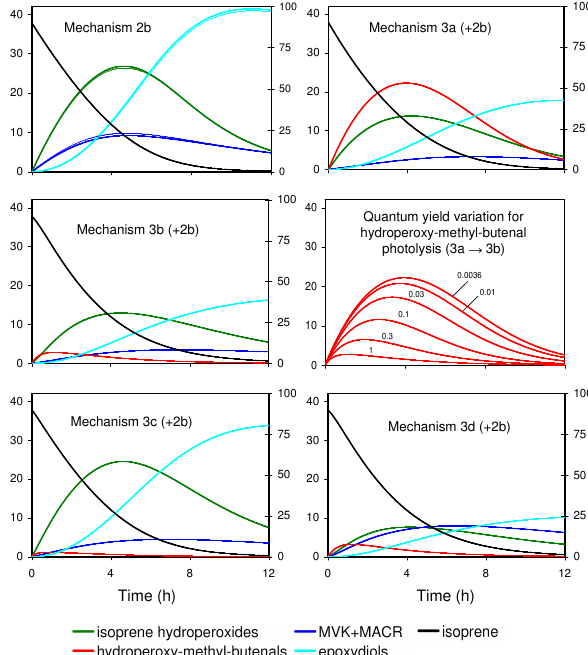
Fig. 8. Mechanism 3 scoping simulations for conditions repre- sentative of the H 2 O 2 -isoprene-air blacklight photolysis experi- ment reported in Fig. 1 of Paulot et al. (2009a), using Mecha- nism 2b as a reference (and with the associated epoxydiol forma- tion also included in the Mechanism 3 variants). Isoprene mix- ing ratios (ppb) on right-hand axes; other species (ppb) on left- hand axes. Thin lines in Mechanism 2b panel show the influence of replacing parameterised RO 2 permutation reactions by an ex- plicit representation, based on Jenkin et al. (1998). Initial condi- tions: 1.66ppm H 2 O 2 and 90ppb isoprene. Calculations assumed a representative blacklight spectrum emitting over the range 330– 400nm ( λ max ≈ 355nm). Intensity scaled to achieve a factor of 3 reduction in isoprene mixing ratio after 4 hours. Absorption cross sections and quantum yields for H 2 O 2 taken from Atkinson et al. (2004); absorption cross sections for methacrolein taken from Atkinson et al. (2006), with a quantum yield of 0.0036, as optimised by Pinho et al. (2005). Parameters for the hydroperoxy-methyl- butenals (HPC41CHO and HPC42CHO) based on methacrolein in Mechanism 3a, and on the methacrolein absorption cross sections in conjunction with a unity quantum yield in Mechanisms 3b, 3c and 3d. The effect of intermediate quantum yields on the simulated hydroperoxy-methyl-butenal profile is also shown for the transition from Mechanism 3a to 3b. Observed hydroperoxide mixing ratio after 3h photolysis ≈ 18ppb (Paulot et al., 2009a). Respective sim- ulated hydroperoxide mixing ratios after 3h photolysis are 23, 13, 12, 22 and 7ppb with Mechanisms 2b, 3a, 3b, 3c and